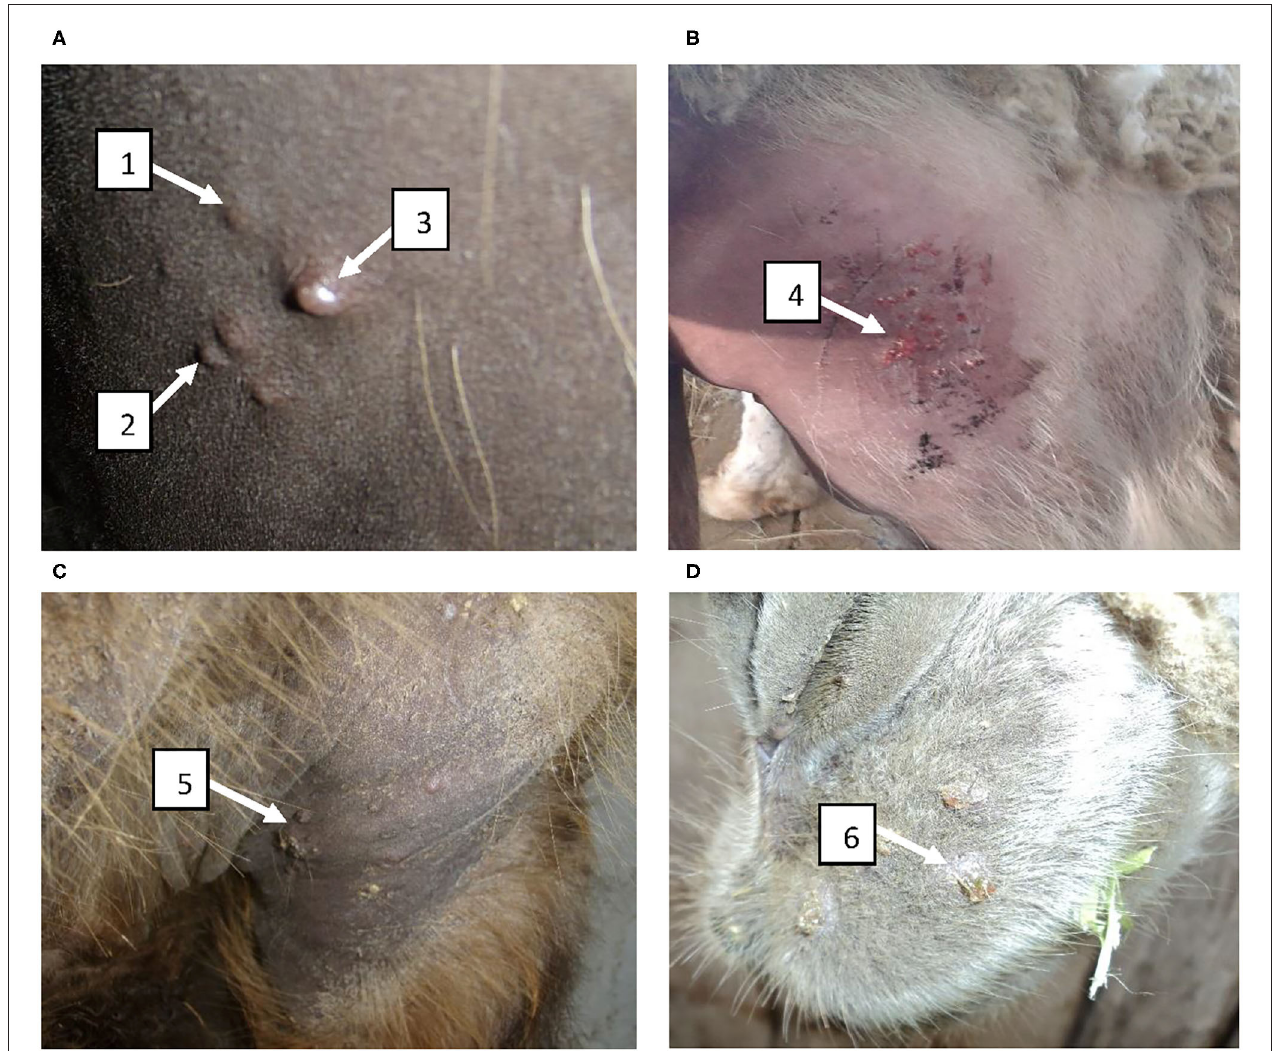
FIGURE 5 | Clinical manifestation of disease in vaccinated camels infected with the virulent wild-type virus during determination of the immunizing dose of the vaccine. (A) Formation of papules, pustules and vesicles at the sites where the virus suspension was administered at 6–9 days after infection; (B) Formation of vesicles from pustules which became pox crusts by 11–14 days; (C) Development of pox lesions in the perineum at the anterior site at 11 days after infection; (D) Development of pox lesions on the lips at 11 days after infection. 1 – papule; 2 – pustule; 3 – vesicle; 4 – formation of pox crust; 5 – pox crust in the perineum of the front limbs of a camel; 6 – pox crust on the lips of a